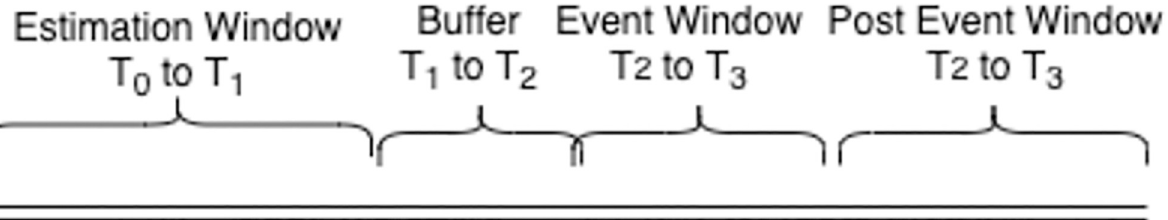
Fig 2. Timeline of the event. T 0 to T 1 is the window used for model estimation. A buffer window is kept between the estimation and the event window to prevent any information leakage. The event window is T 2 to T 3 , so that the day of the event t = 0 lies within the event window.